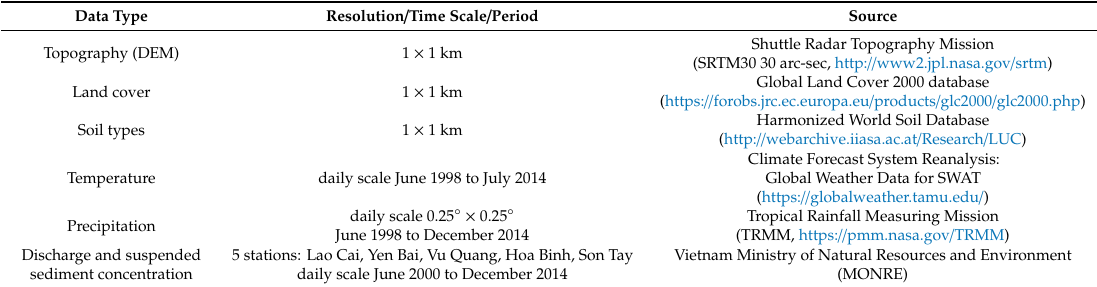
Table 2. SWAT Inputs and Hydrology Datasets .